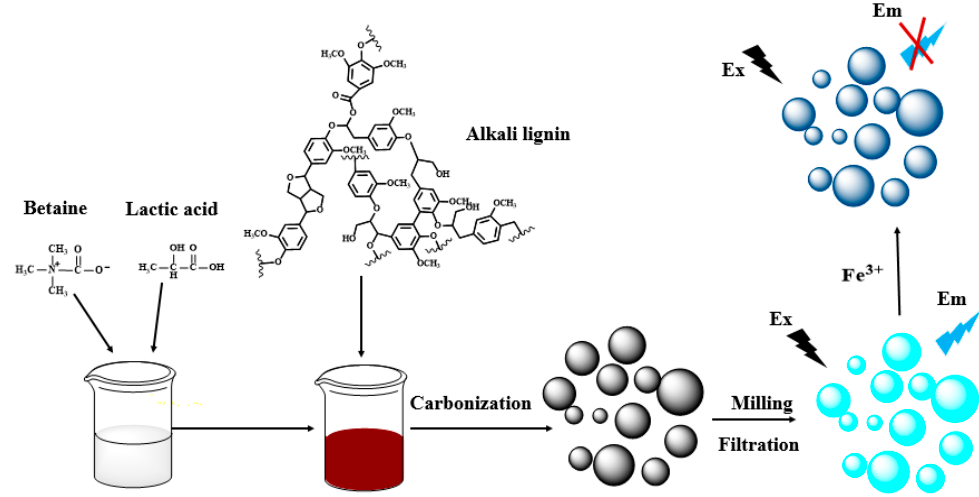
Scheme 1. Schematic representation of synthesis of N-L-CQDs and illustration of the fluorescence